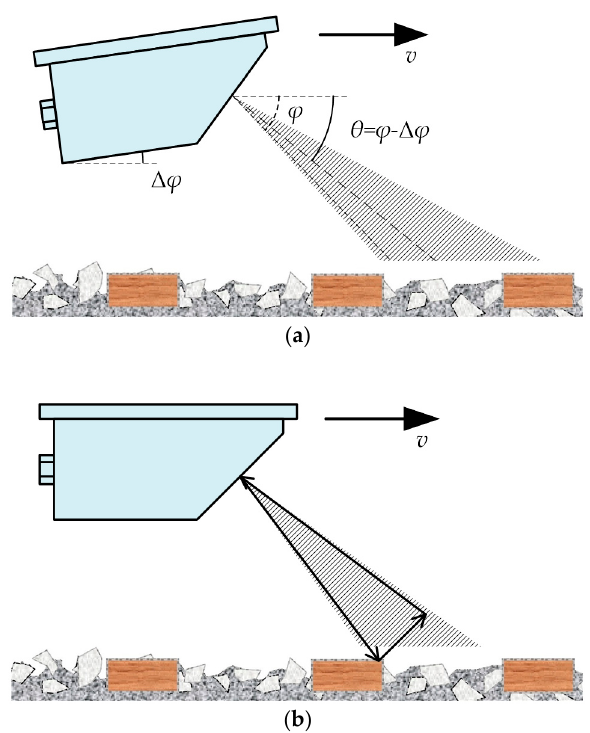
Figure 3. Problems of train-borne single-channel DRS: ( a ) Angle deflection problem caused by the installation deviation and the jolt of motion; ( b ) Multipath effect problem.